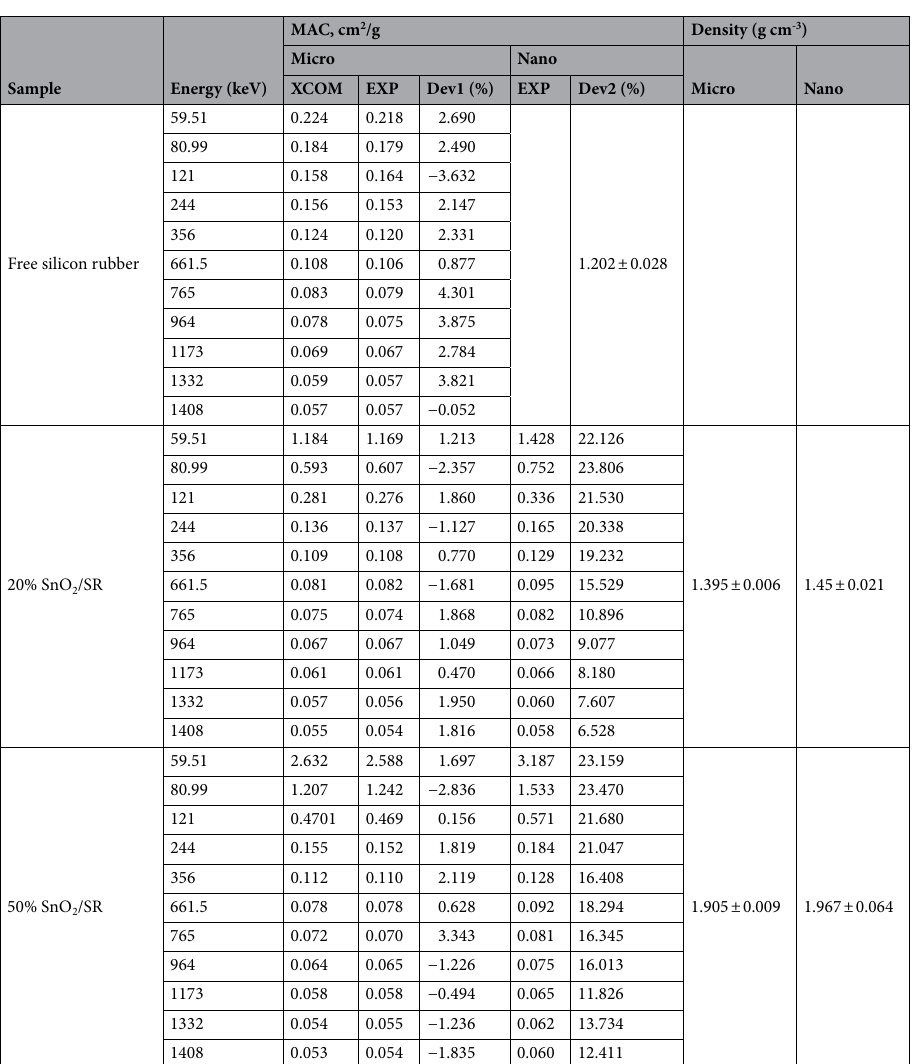
Table 2. Mass attenuation coefficients, theoretical Xcom, relative deviation, measured linear attenuation coefficient, and measured density, value for free SR, micro-SnO 2 /SR, and nano-SnO 2 /SR